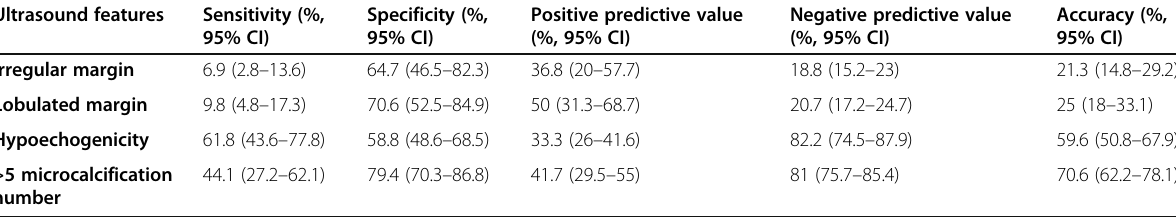
Table 3 Diagnostic value of sonographic features in predicting malignancy for the thyroid nodules with microcalcification Ultrasound